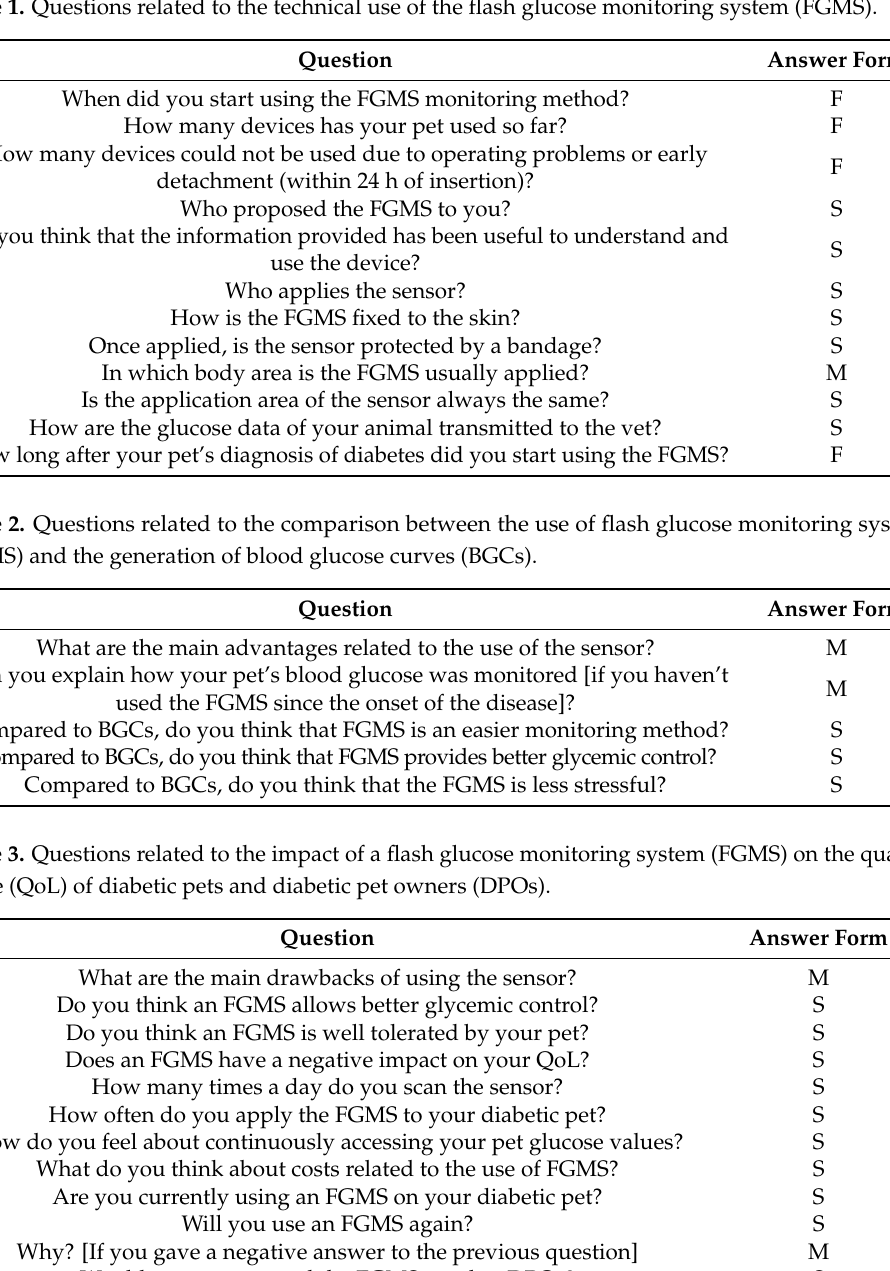
Table 1. Questions related to the technical use of the flash glucose monitoring system (FGMS).